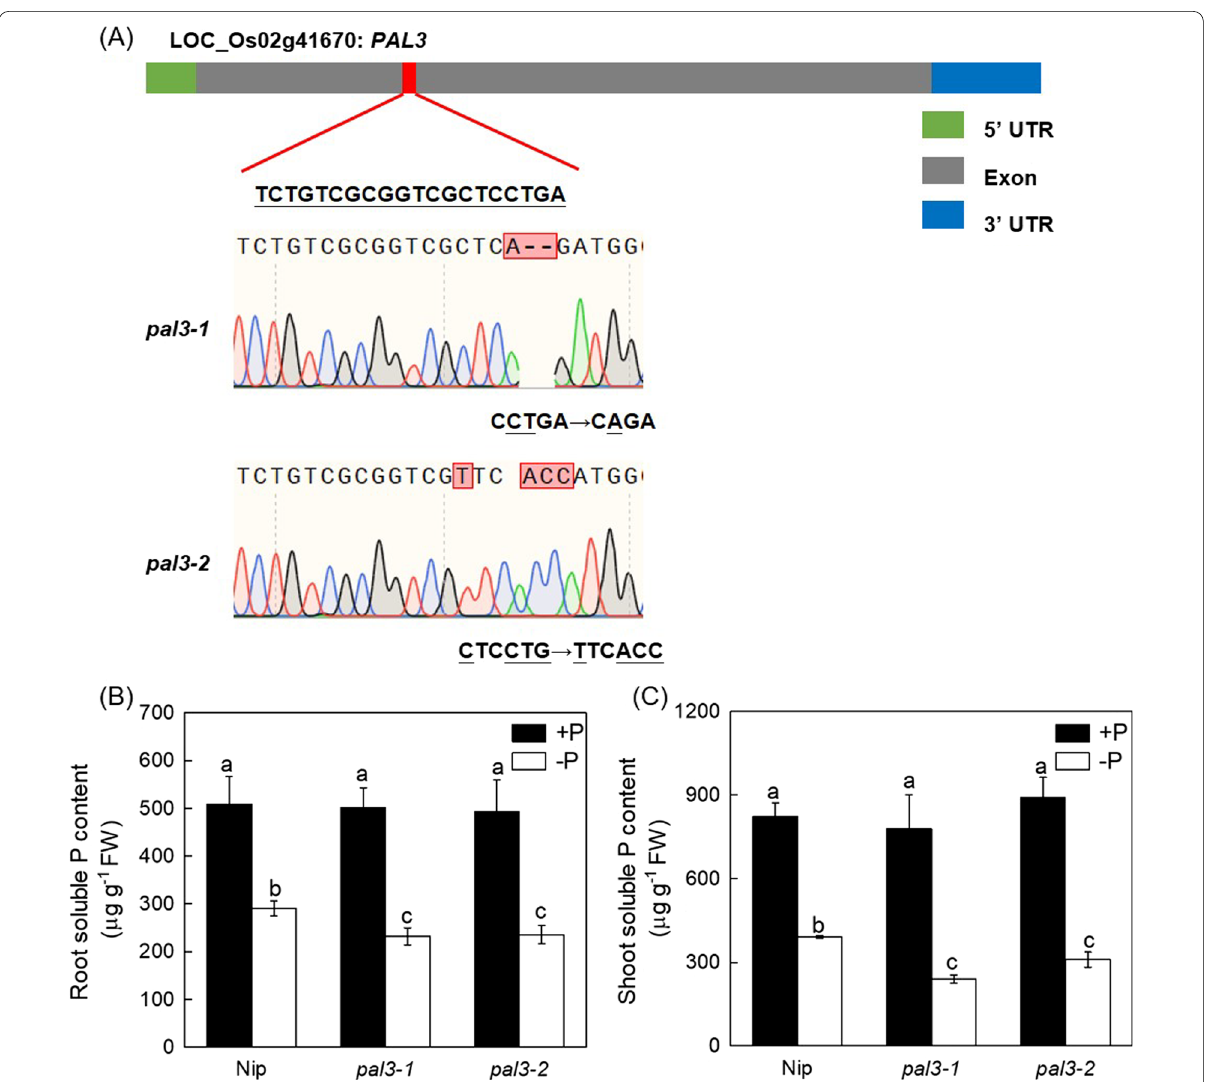
Fig. 3 The effect of endogenous SA on the soluble P content in rice. ( A ) PAL 3 target loci. The gRNA targeting site was designed in the exon of PAL 3, two kinds of mutations were generated using CRISPR‑Cas9 technology. Root and shoot soluble P content ( B and C ) in rice were measured. Data are means SD ( n 4). Different letters represent significant differences by Duncan’s multiple range test at the P < ± =